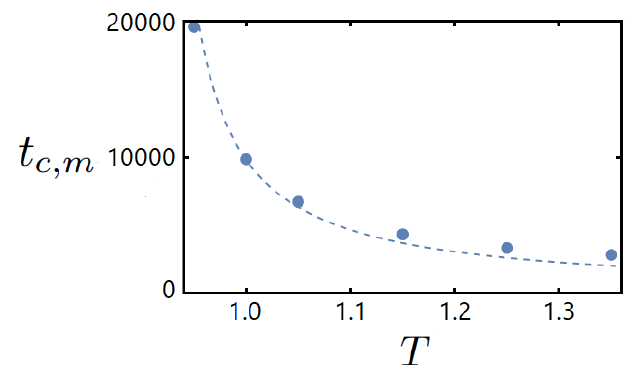
= 0.2 0 (cid:128) T − T (cid:138) − 1 c , with T c T c